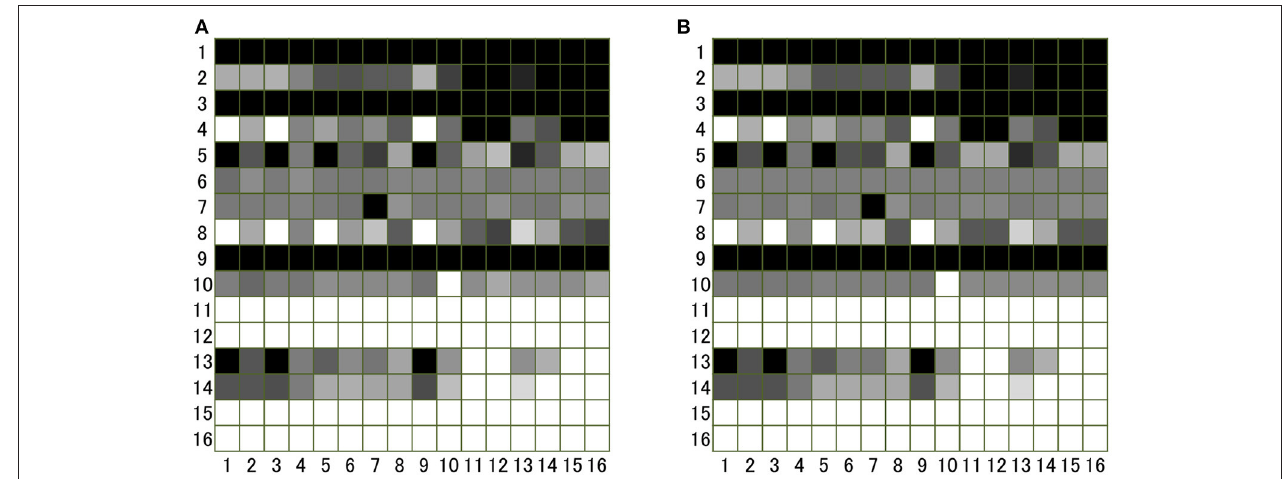
FIGURE 1 | Image matrix s ij ( i , j = 1, ··· 16) produced by (A) an individual based simulation and (B) the analytical method described in the text. In order to generate (A) , an individual simulation with 3,200 agents was run (each norm has 200 individuals). In the simulation, each individual plays the donation game as the donor 100 times on average with different randomly chosen recipients (i.e., 320,000 games in total). This number of games is large enough for the process to reach the equilibrium. After each game, all individuals, following their own norms, assess the donor and label “1” or “0” to the individual. After 320,000 games, the number of individuals with norm j of whom the individuals with i has image “1” is counted and the number is divided by 200 (total number of individuals with j ) to obtain s ij . The value of s ij is shown in gray scale, in which white corresponds to “1,” and black to “0”.